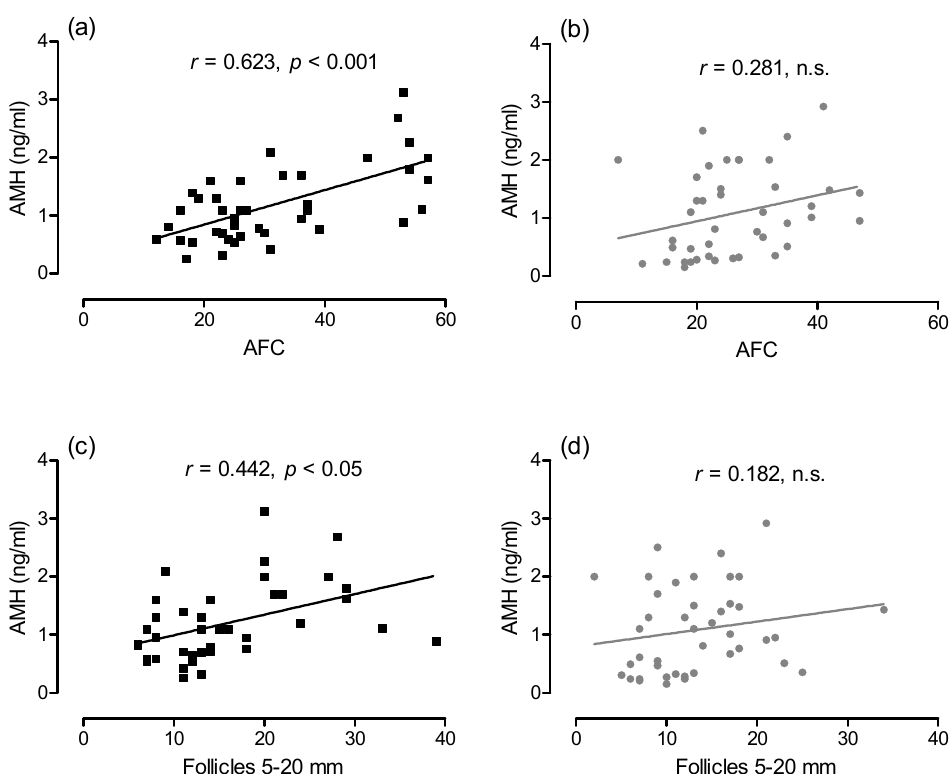
Figure 4. Correlation of AMH and antral follicle count (AFC) in mares of experimental group DES (( a ); 9.4 mg slow-release deslorelin black squares), and CON (( b ); 1.25 mg short-acting deslorelin, grey circles). The AFC was positively correlated ( r = 0.623, p < 0.001) in group DES but not in group CON ( r = 0.281, not significant [n.s.]). Correlation of AMH and number of follicles 5 to 20 mm in diameter in DES (( c ), r = 0.422, p < 0.05) and CON (( d ), r = 0.182, n.s.).